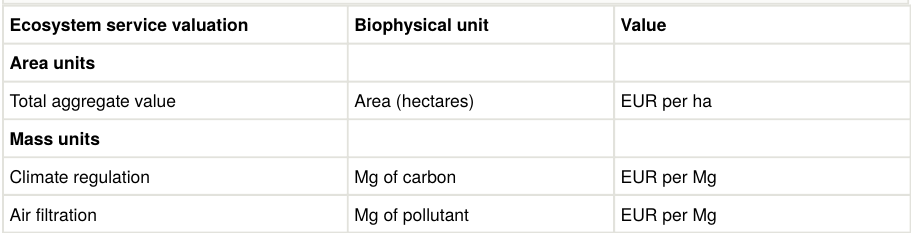
Examples of di ff erent units for value